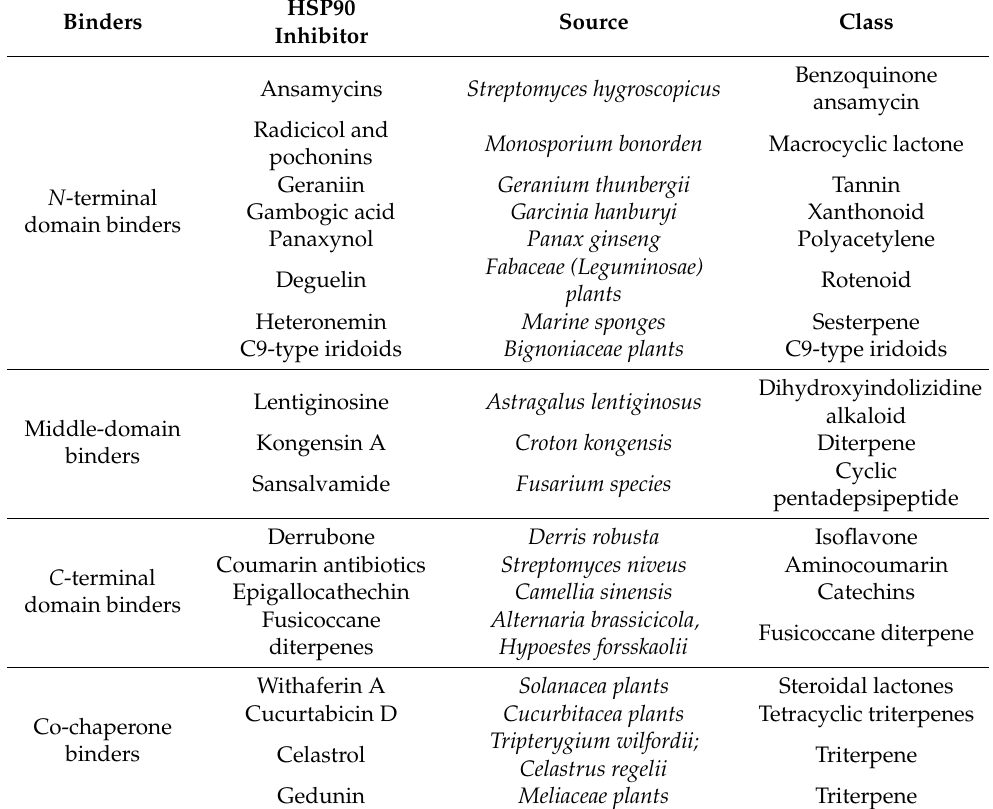
Table 1. Natural products acting as HSP90 inhibitors grouped depending on their binding